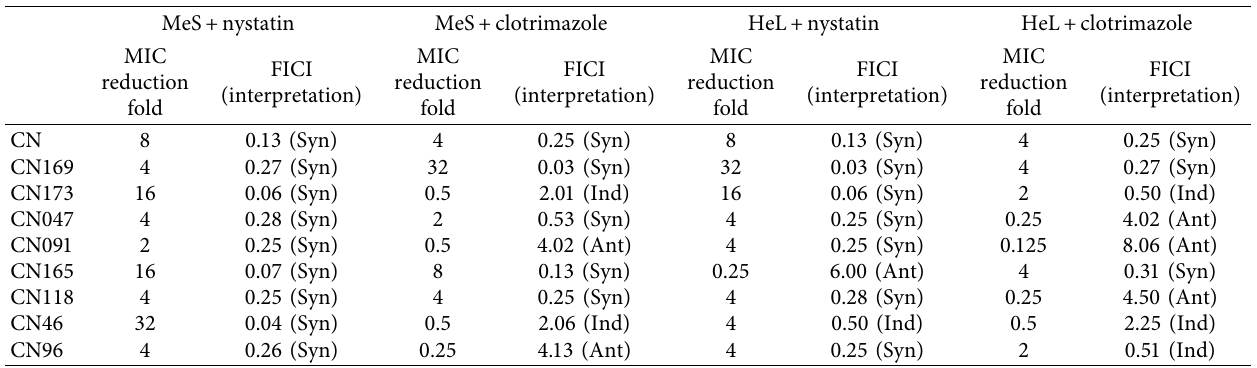
Table 3: Effect of the combination of methanol extract of seeds (MeS) and hexane extract of leaves (HeL) with nystatin and